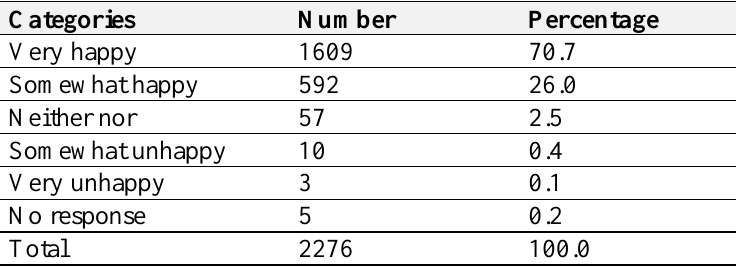
Table 4. Frequency distribution of Happiness